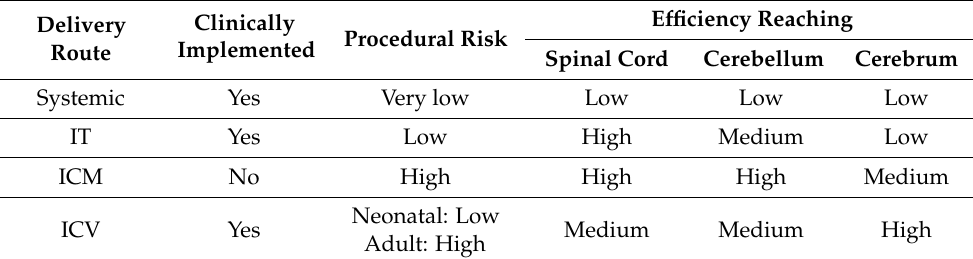
Table 3. Main routes of administration for human CNS gene delivery.